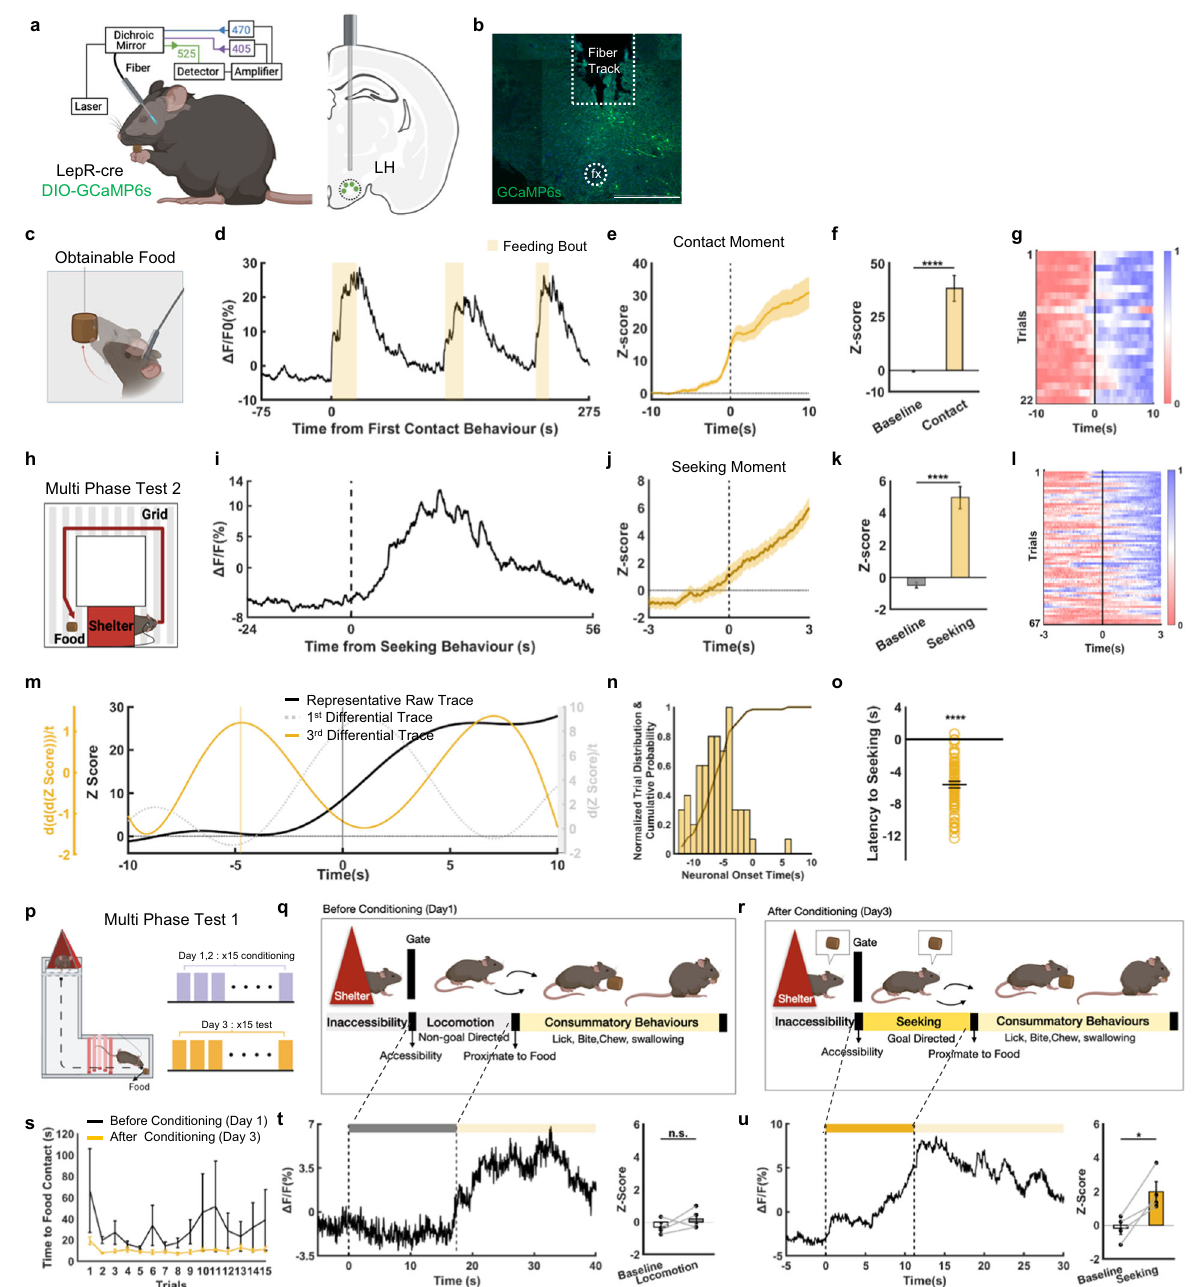
Fig. 2 | Activity of LH LepR neurons is time-locked to seeking and consummatory behaviours. a Schematic of virus injection/ fi bre insertion for fi bre photometry in LHfromLepR-cremice. b ArepresentativeimagevalidatesGCaMP6sexpressionin LepR neurons and optical fi bre tract above the LH. Scale bar: 500 µ m. The experi- mentwasrepeated5timesindependentlywithsimilarresults.fx,fonix. c Schematic of the consummatory behaviour test 1 (obtainable). d Representative calcium tra- ces from LH LepR neurons. Yellow shaded box: from the moment of food contact to the end of food consumption. e Average Z-score from LH LepR calcium response alignedtocontactwithfood(5mice,22trials). f Quanti fi cationofZ-scoreincalcium signalchangefrom( e ).Comparisonbetweenbaseline( − 8to − 7s)andaftercontact (9 to 10s). g Heatmap depicting normalised LH LepR neural activity aligned to the moment of contact with food. h Schematic of the multi-phase test 2. i , j Representative calcium traces ( i ) and average Z-score ( j ) from LH LepR neural calcium signal response aligned to voluntary seeking initiation (4 mice, 67 trials). k Quanti fi cation of Z-scorein calcium signalchangefrom ( j ). Comparison between baseline ( − 8 to − 7s) and after voluntary seeking behaviour (2 to 3s). l Heatmap